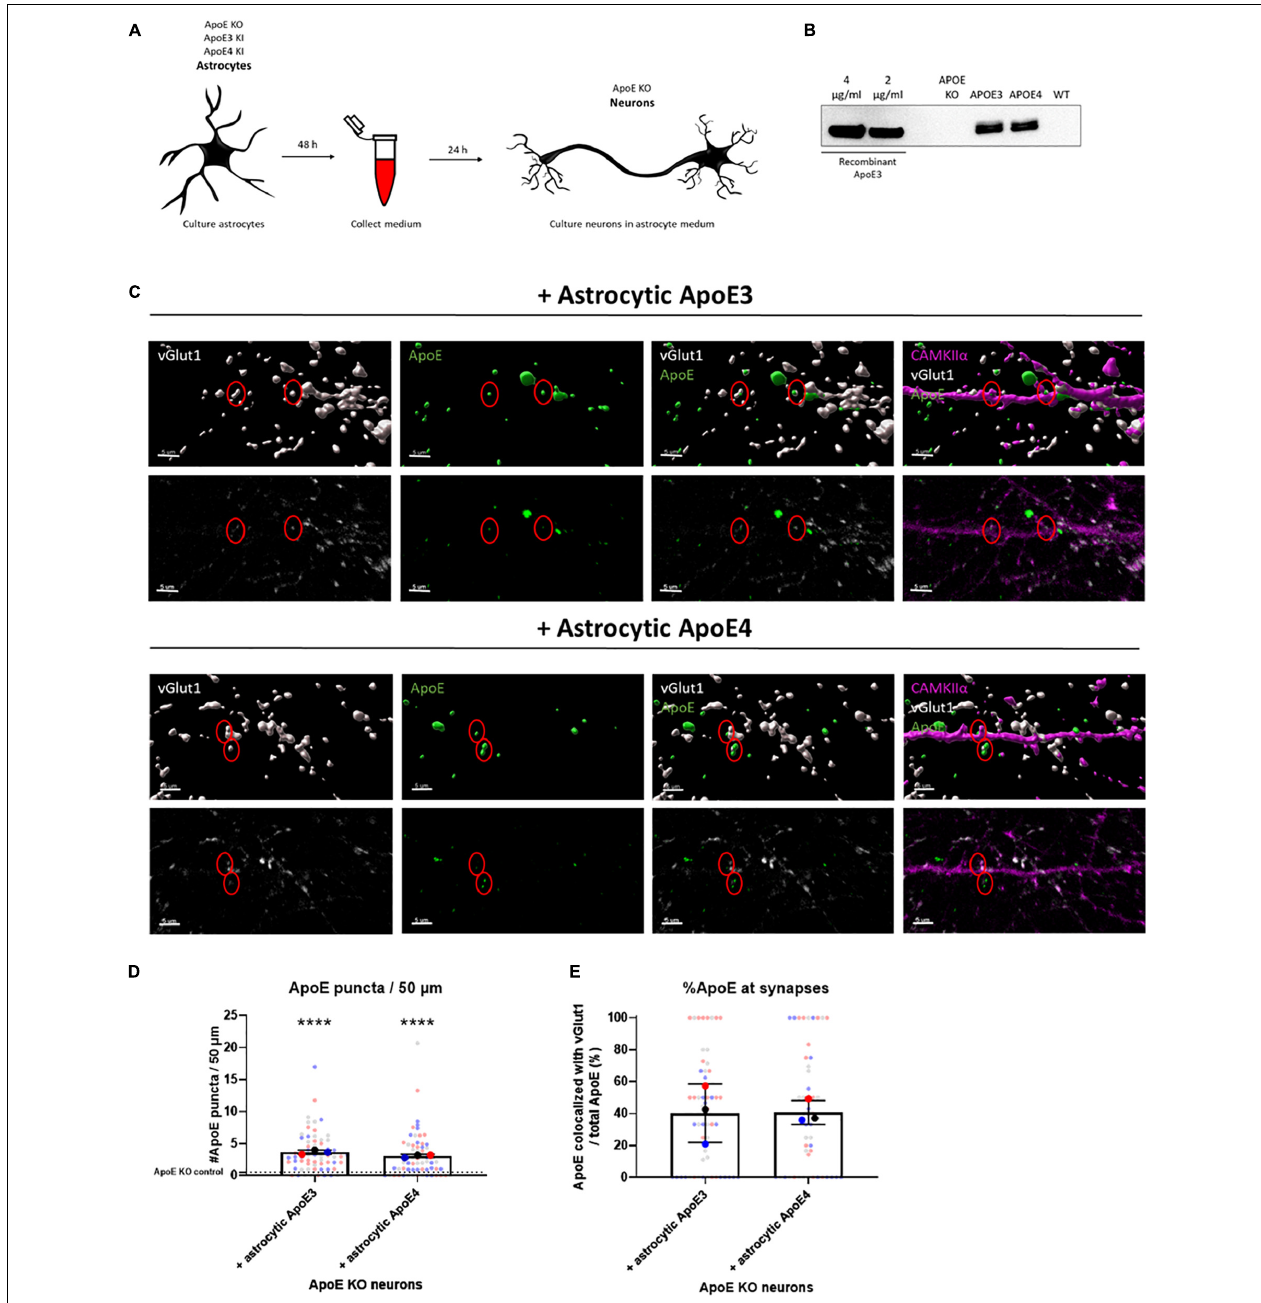
FIGURE 1 | Astrocytic ApoE is detected at synaptic terminals in ApoE KO neurons cultured in ApoE3 and ApoE4 astrocyte conditioned medium for 24 h. (A) Schematic overview of astrocyte conditioned medium collection and treatment of ApoE KO primary neuron cultures. (B) Representative Western blot analysis of ApoE protein levels in conditioned medium from human ApoE3 and ApoE4 mouse astrocytes after 48 h. ApoE KO- and wild-type (WT) conditioned medium were added as negative controls. The different concentrations of recombinant ApoE3 give an indication of ApoE concentration in media. (C) Representative 3D reconstructed images (upper panels) and original confocal images (lower panels) of ApoE (green) and vGlut1 (gray) co-localization in ApoE KO neurons (19 DIV) cultured with ApoE3- and ApoE4-medium for 24 h. CAMKII α (magenta) was used as a marker to identify glutamatergic neurons. Scale bar is 5 µ m. A red circle indicates ApoE puncta at/close to vGlut1-postive synapses. (D) Quantification of ApoE puncta at/close to neurites analyzed using ICY spot detector ( N = 3 embryos; n = 63 neurites per condition). The puncta detected in neurons cultured in astrocytic ApoE KO medium are indicated by a dotted line. **** p < 0.0001. (E) Quantification of the percentages of ApoE puncta co-localizing with vGlut1-positive presynaptic terminals using ICY colocalizer in relation to total ApoE puncta ( N = 3 embryos; co-localization was analyzed in neurites containing ApoE puncta only, n ApoE 3 = 55 neurites, n ApoE 4 = 48 neurites). The data were shown in superplots to show the variation on both embryo and cell level. Data were expressed as mean ± SD. Statistical analyses were performed using Kruskal Wallis test followed by Dunn’s multiple comparisons test (D) or Mann Whitney test (E) . **** p < 0.0001.